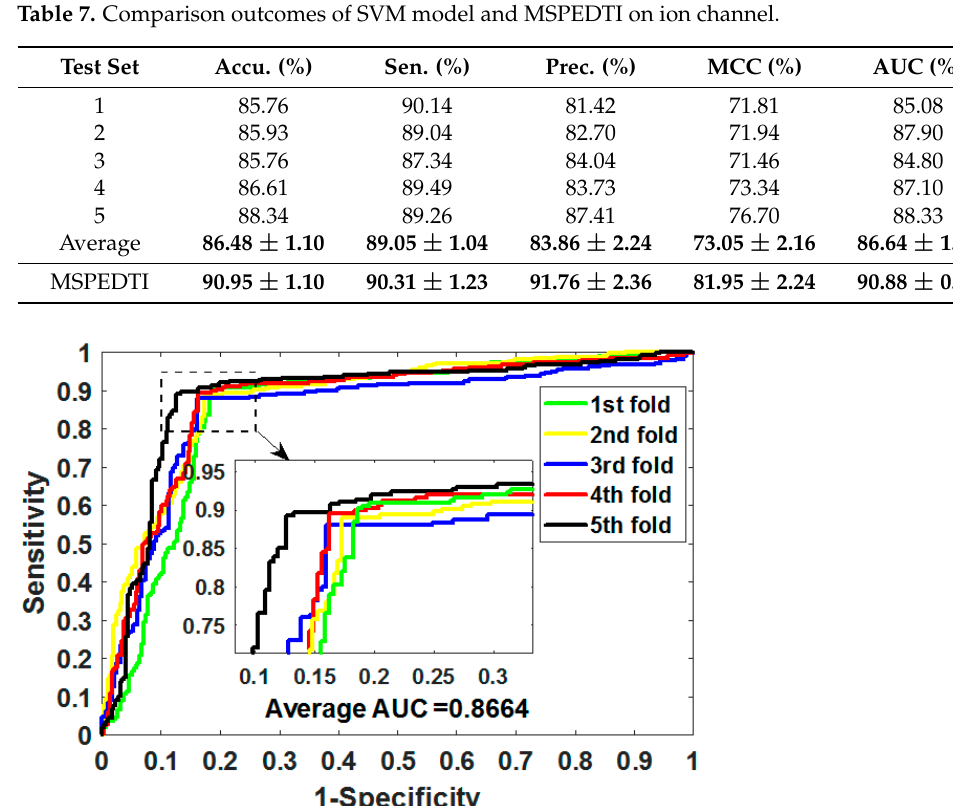
Figure 7. ROC curves plotted by the SVM classifier model on ion channel .